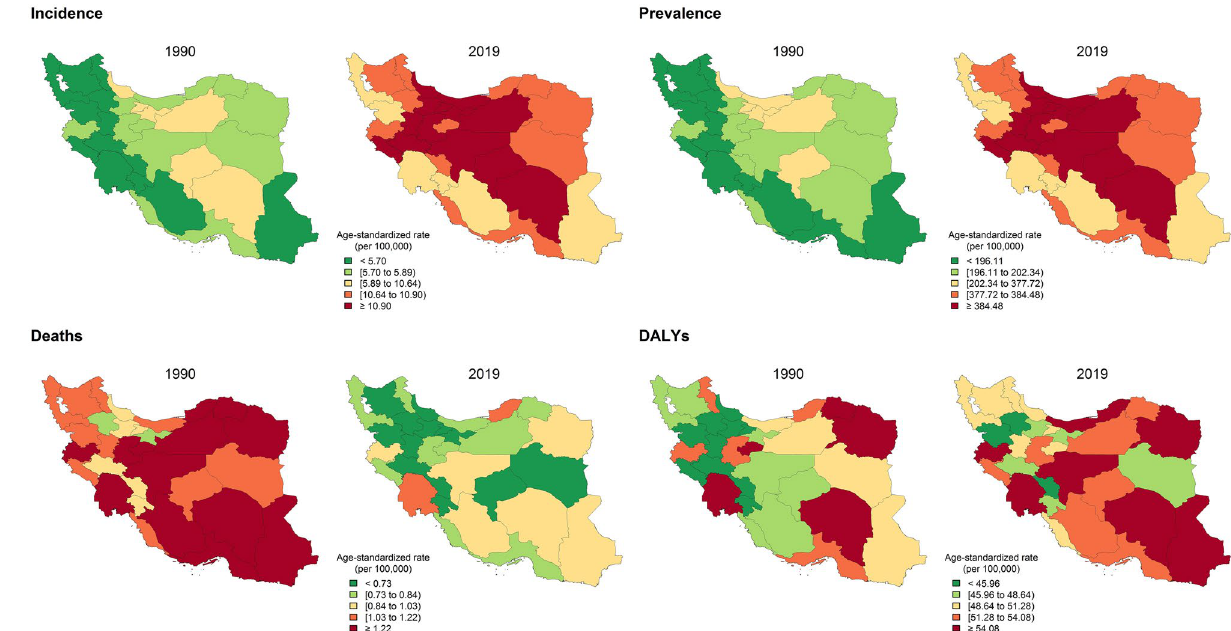
Figure 2. The map of Iran by the measures of incidence, prevalence, deaths, and DALYs of T1DM in 1990 and 2019 in 31